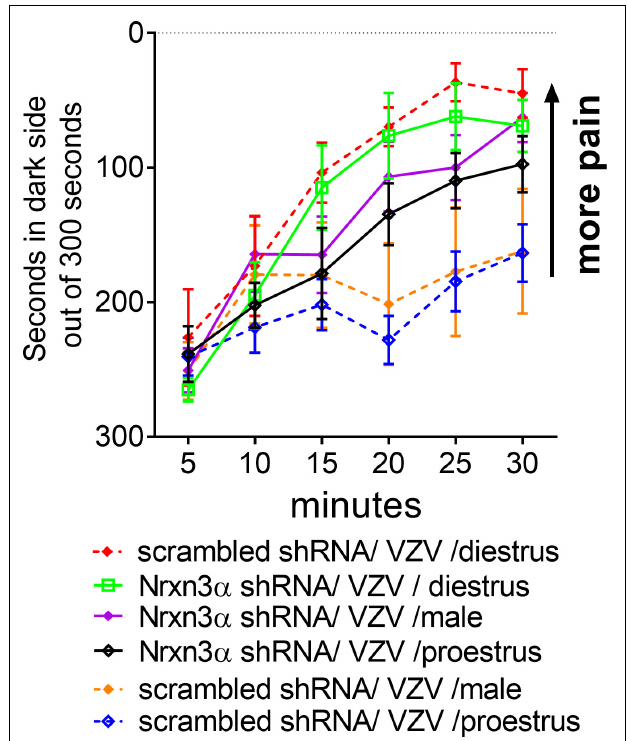
FIGURE 2 | Attenuating Nrxn3 α expression in the central amygdala increased VZV associated pain. The central amygdala of male and female rats were bilaterally infused with lentivirus expressing either scrambled shRNA (control shRNA) or Nrxn3 α shRNA. The right lateral parabrachial was infused with AAV1 containing an engineered GABA receptor (iGABASnFR) and a permanent optical fiber was implanted in the right lateral parabrachial. Four weeks after brain surgery the left vibrissae pad was injected with VZV. 2 weeks after VZV injection pain behavior was measured in males and at specific estrous cycle phases in